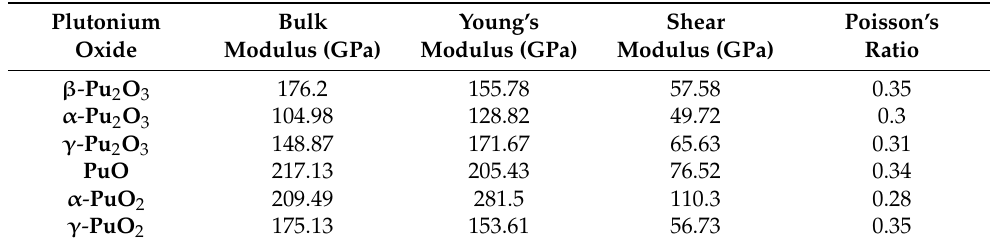
Table 3. Values of the Young’s modulus (E), Bulk modulus (B) and Shear modulus (G) (in GPa), and Poisson’s ratio (v) of each plutonium